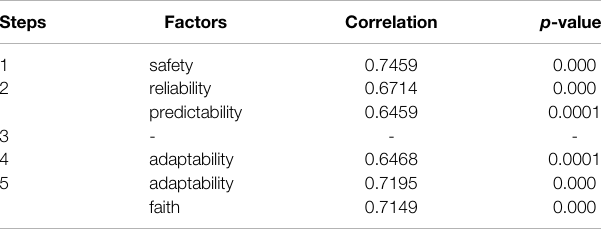
TABLE 3 | Factors strongly correlated with trust in accumulation phase over the fi ve steps (Spearman r s (cid:1) 0 . 6 , α (cid:1) 0 . 05). Multiple factors show consistent correlation with trust.